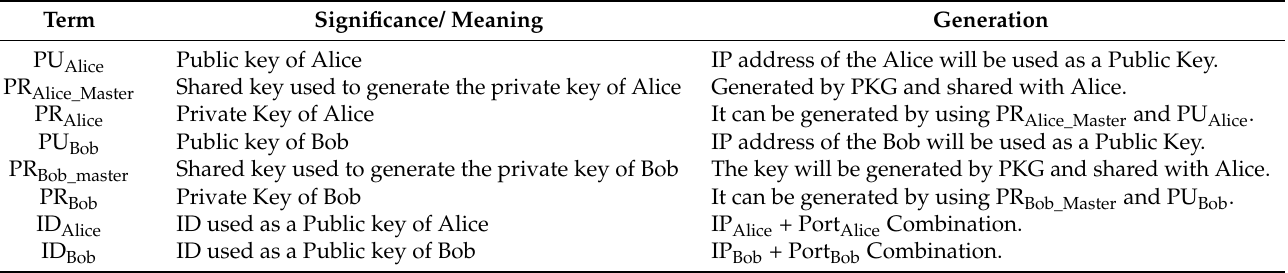
Table 4. Terms used in